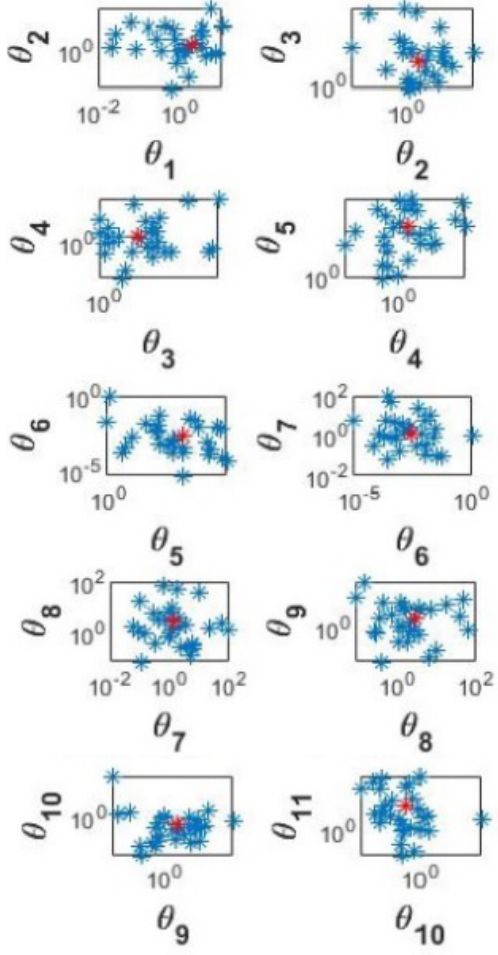
Figure 9. 90% confidence regions for the parameters from Equation (1). θ 1 to θ 11 stand for log the parameters e 1 , e 2 , e 3 , a 3 , n, T, T I , n I , α E 2 , m and e 4 , respectively. Expected values are shown by the red